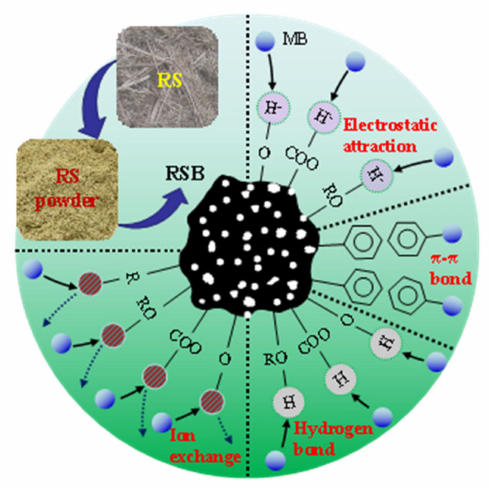
Figure 15. Adsorption mechanism of RSB for